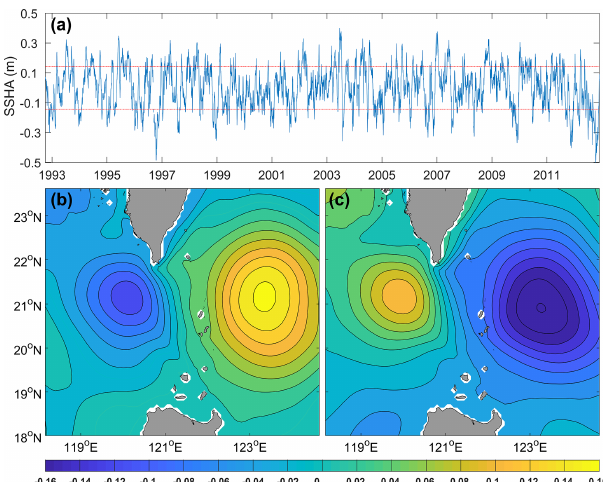
Figure 3. Time series of intensity index of counter-rotating eddy pair in LS (a) . Red dotted line above (below) represents the sum (difference) of one time the standard deviation and the average value of the time series. Composition of SSHA for positive (b) and nega- tive (c) intensity-index days. SSHA interval is 0.02m. Figure based on HYCOM